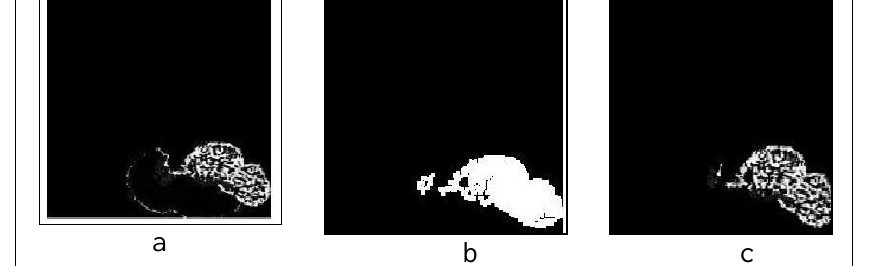
Fig. 7: a) Class of FCM include tumor, b) Binary image of extracted tumor, c) Extracted